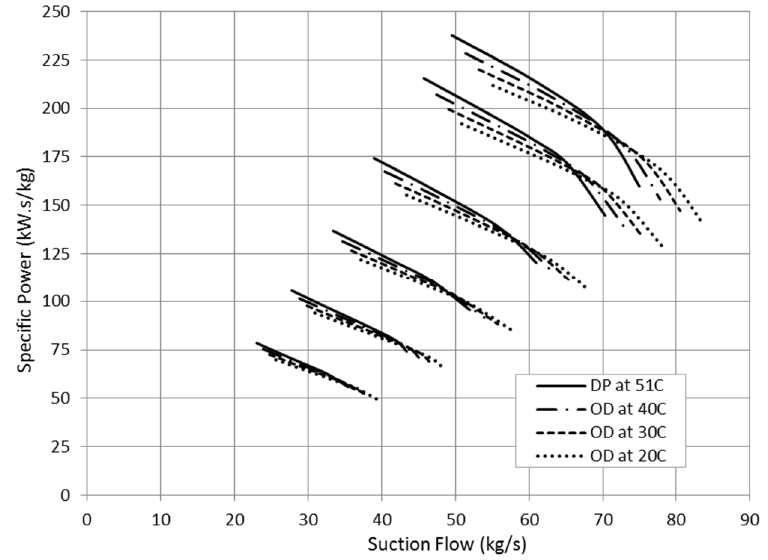
Figure10. Effect of gas temperature variation on compressor specific